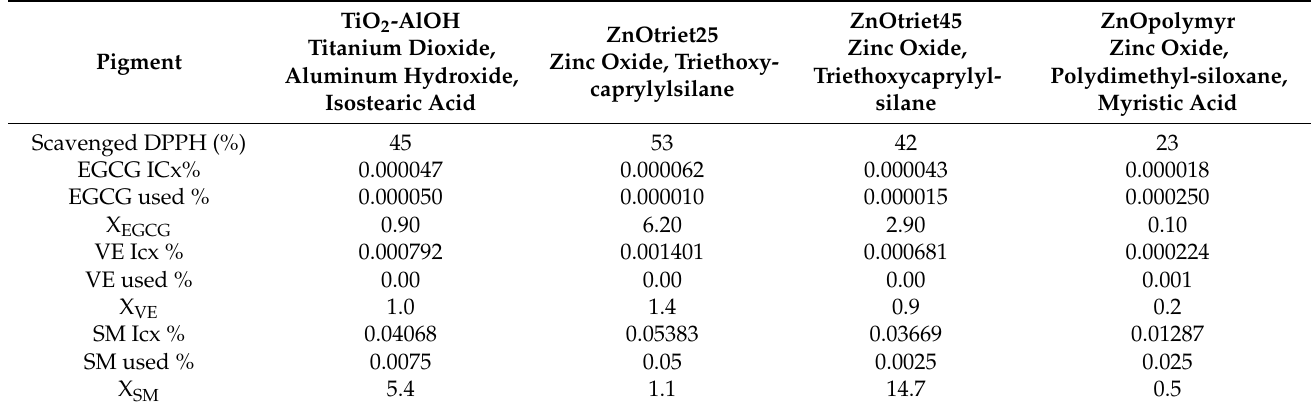
Table 2. Scavenged DPPH in % by different physical filters during UV irradiation in solution, theoretically calculated amount of selected antioxidants ICx to counteract this radical formation, used amount of selected antioxidants to counteract the radical formation and the factor X between calculated and used amount of selected antioxidants (EGCG = Epigallocatechin Gallate, VE = Alpha- Tocoperol/Vitamin E, SM = Sodium metabisulfite).